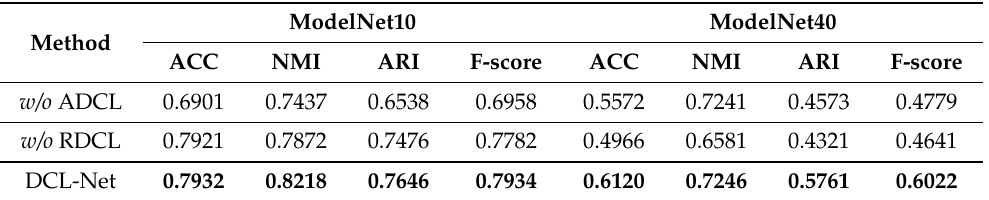
Table 2. The evaluation of the proposed RDCL module and ADCL module.